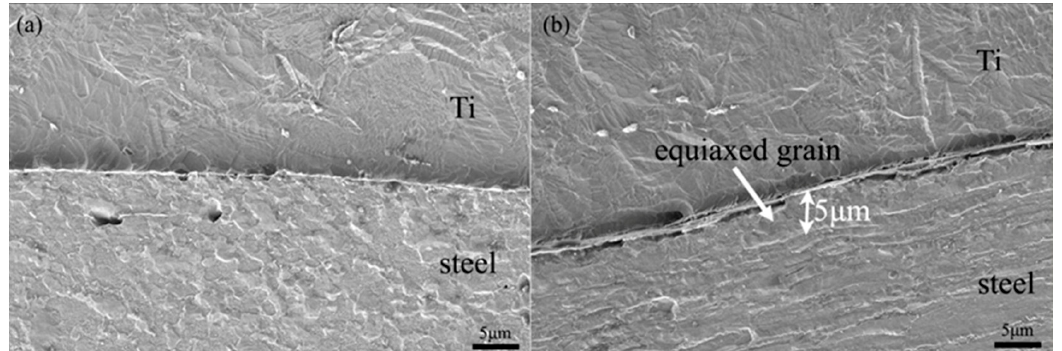
Figure 4. SEM images of the detailed interfacial microstructure in an explosively welded TA1 / LAS bimetallic sheet: ( a ) magnified image of the typical microstructure near the vortex, ( b ) magnified image of the typical microstructure away from the vortex.